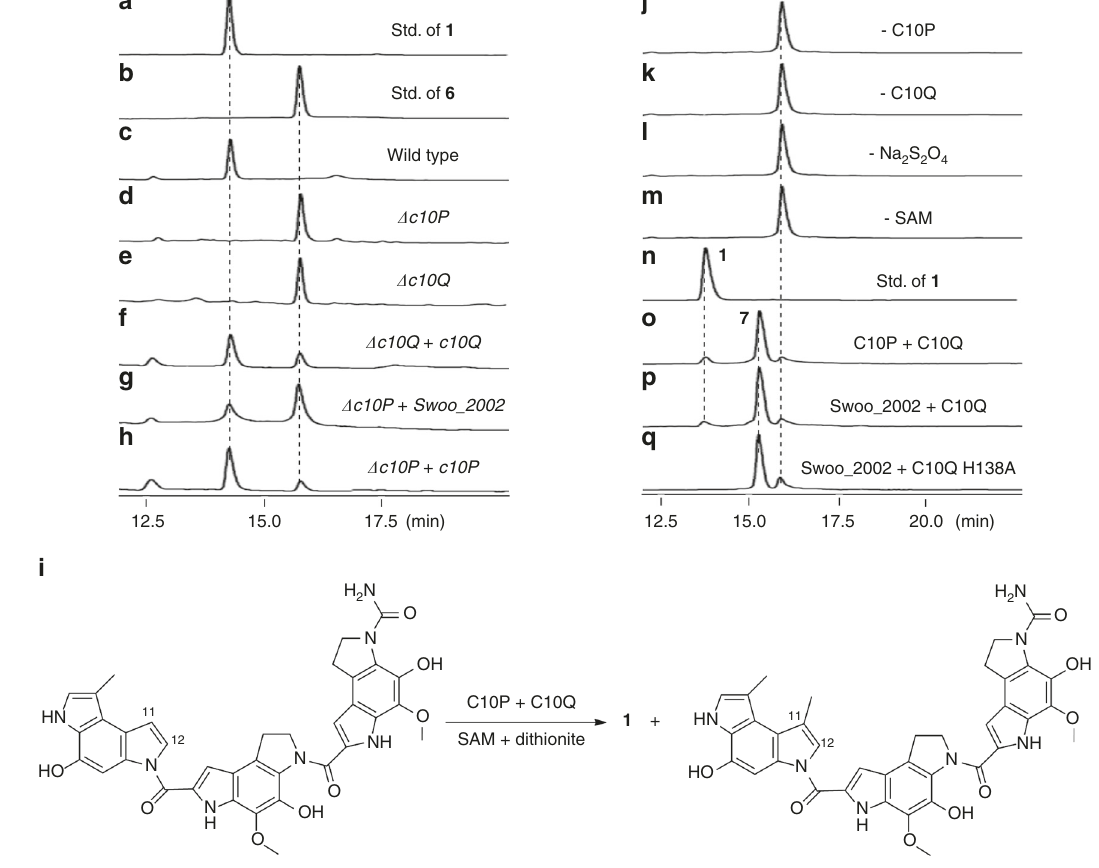
Fig. 2 Characterization of a two-component cyclopropanase system. a – h HPLC analysis of the relevant metabolites (UV at 374 nm). a Standard of 1 . b Standard of 6 . c Wild type Streptomyces zelensis NRRL 11183. d The Δ c10P mutant. e The Δ c10Q mutant. f The Δ c10Q mutant complementated with the c10Q gene. g The Δ c10P mutant complementated with the Swoo_2002 gene. h The Δ c10P mutant complementated with the c10P gene. i Structures of 6 and 7 . j – q HPLC analysis of enzymatic products. j – m are the control reactions without C10P, C10Q, Na 2 S 2 O 4 , and SAM, respectively. n Standard of 1 . o The complete reaction for C10P and C10Q. p The complete reaction for Swoo_2002 and C10Q. q The reaction for Swoo_2002 and C10Q H138A. All the in vitro enzymatic activity assays were performed in an anaerobic glove box with less than 1 ppm of O 2 . Reactions were conducted in Tris (cid:129) HCl buffer (Tris 50 mM, NaCl 100 mM, glycerol 10%, pH 8.0) with the following composition: 1 μ M reconstituted Swoo_2002, 2 μ M C10Q, 10 μ M substrate 6 , 1 mM SAM, 5